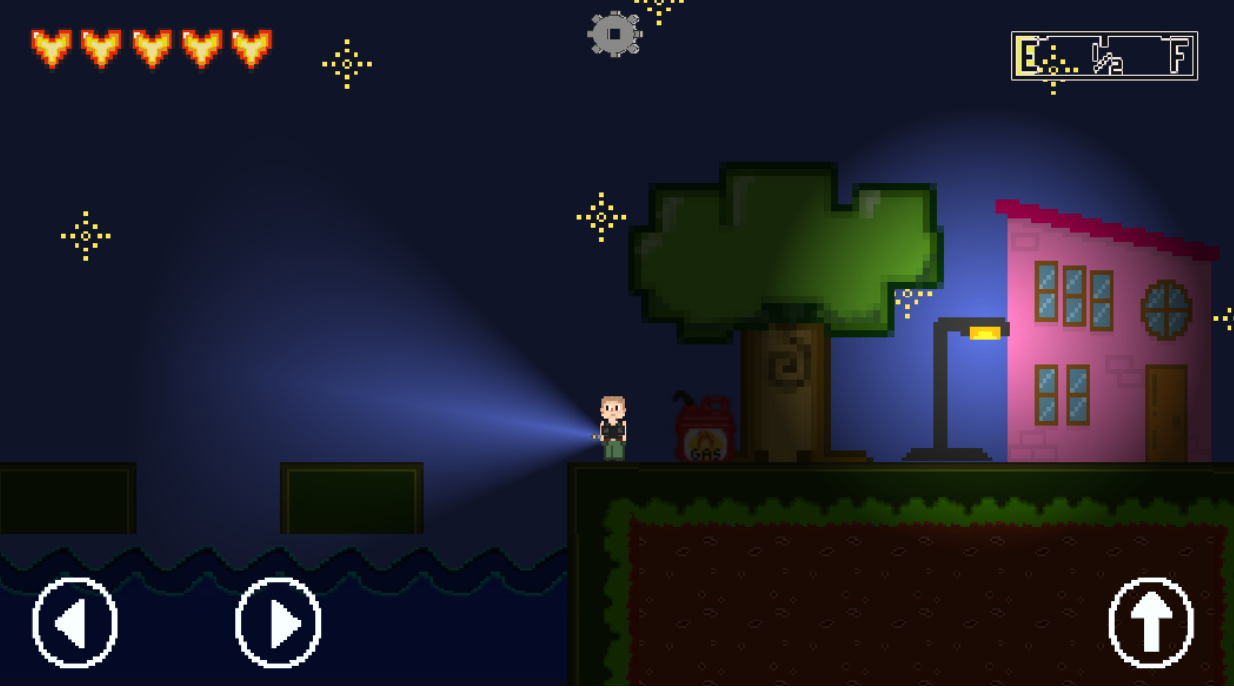
Figure 6. Screenshot of Phase 2.